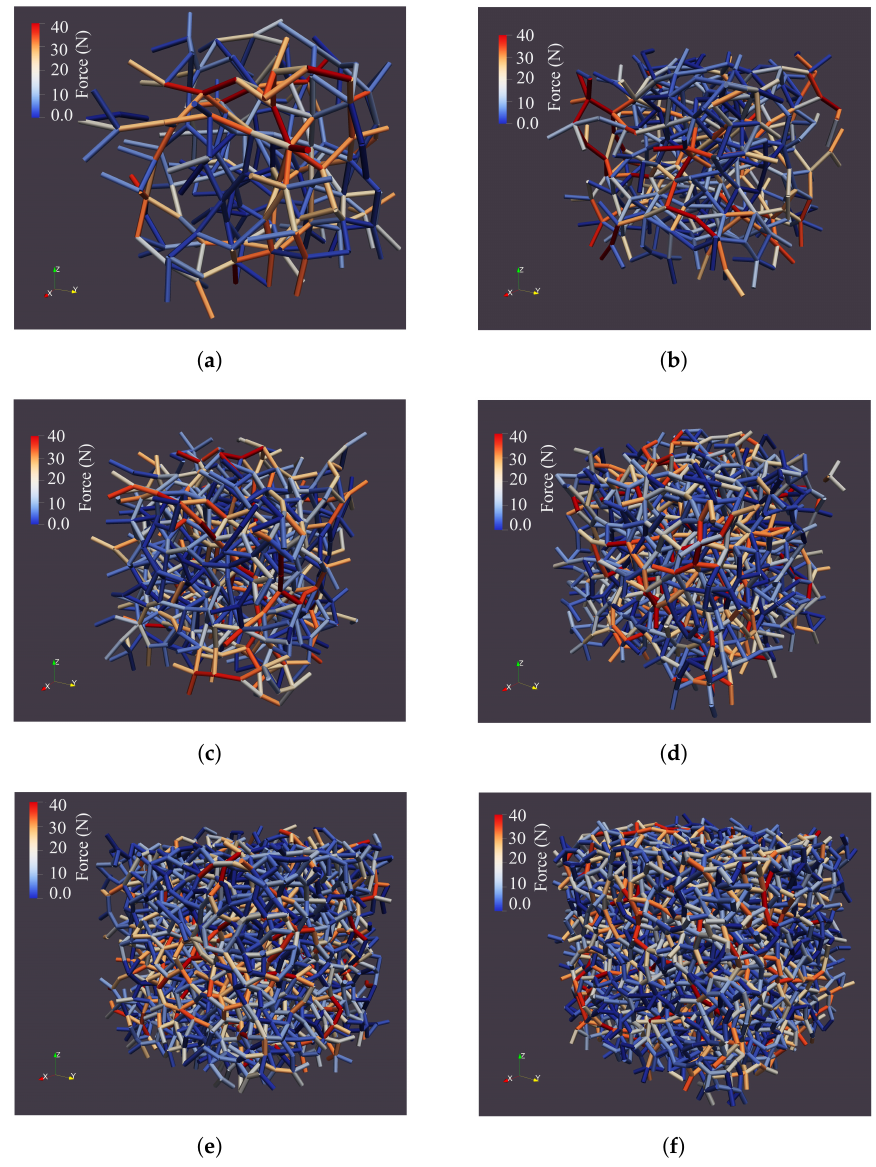
Figure 7. Force chain network for the RVEs with ( a ) 150, ( b ) 300, ( c ) 500, ( d ) 1000, ( e ) 2000, and ( f ) 3000 particles and the periodic boundary